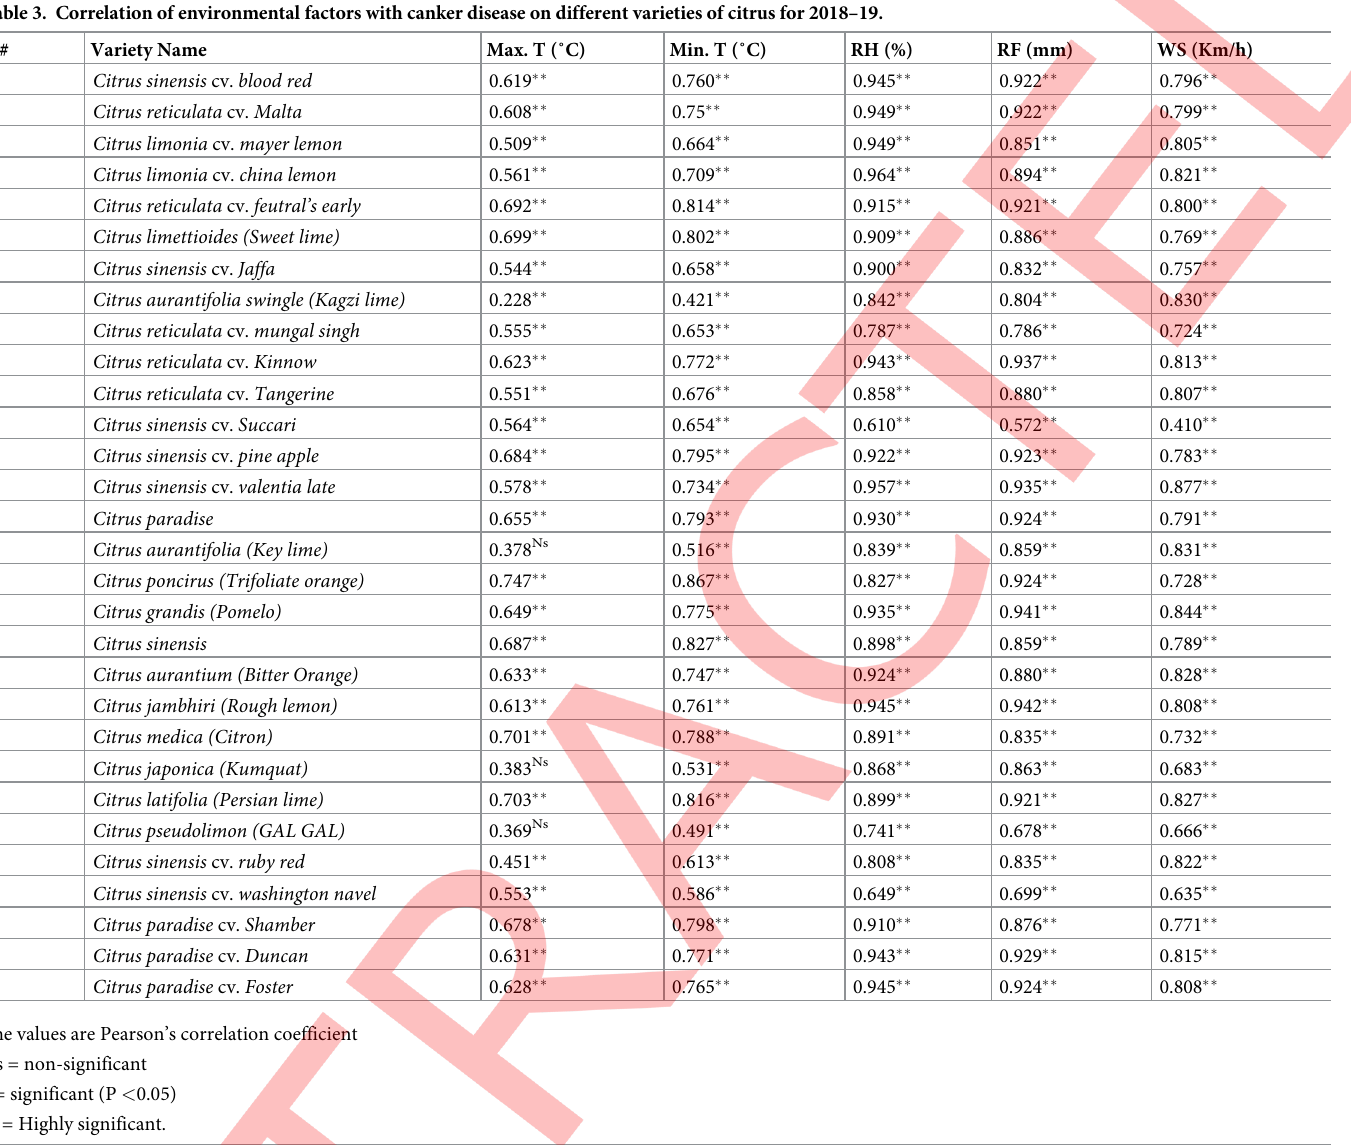
Table 3. Correlation of environmental factors with canker disease on different varieties of citrus for